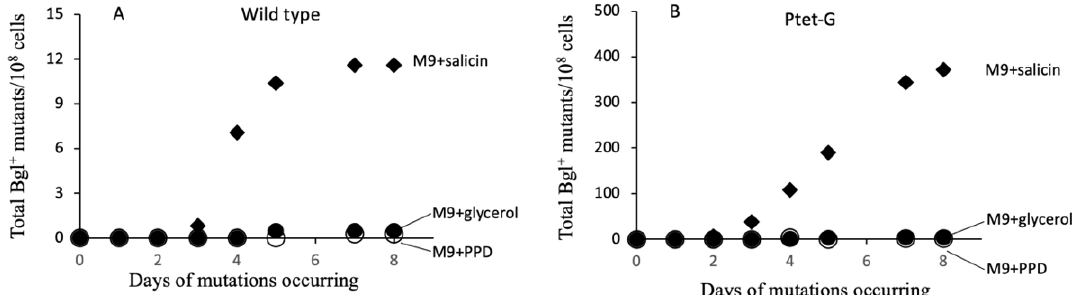
Figure 3. Dependence of Bgl + mutations on b-glucoside. ( A ) Effects of salicin, glycerol and propandiol on Bgl + mutations in wild type cells. ( B ) Effects of salicin, glycerol and propandiol on Bgl + mutations in Ptet-G cells expressing bglG . In ( A , B ), 2 × 10 7 cells were applied to M9 + salicin or glycerol plates while 10 8 cells were applied to M9 + PPD plates. The plates were incubated at 30 ◦ C. For M9 + salicin plates, the Bgl + mutation frequencies were determined as in Figure 1. For M9 + glycerol or PPD plates, the cells were washed off the agar plates and diluted with M9 salts. Appropriate dilutions were applied to LB plates to determine the total cell populations, and to M9 + salicin plates to determine the Bgl + populations. The Bgl + mutation frequencies were determined by dividing the Bgl + populations by the total populations.